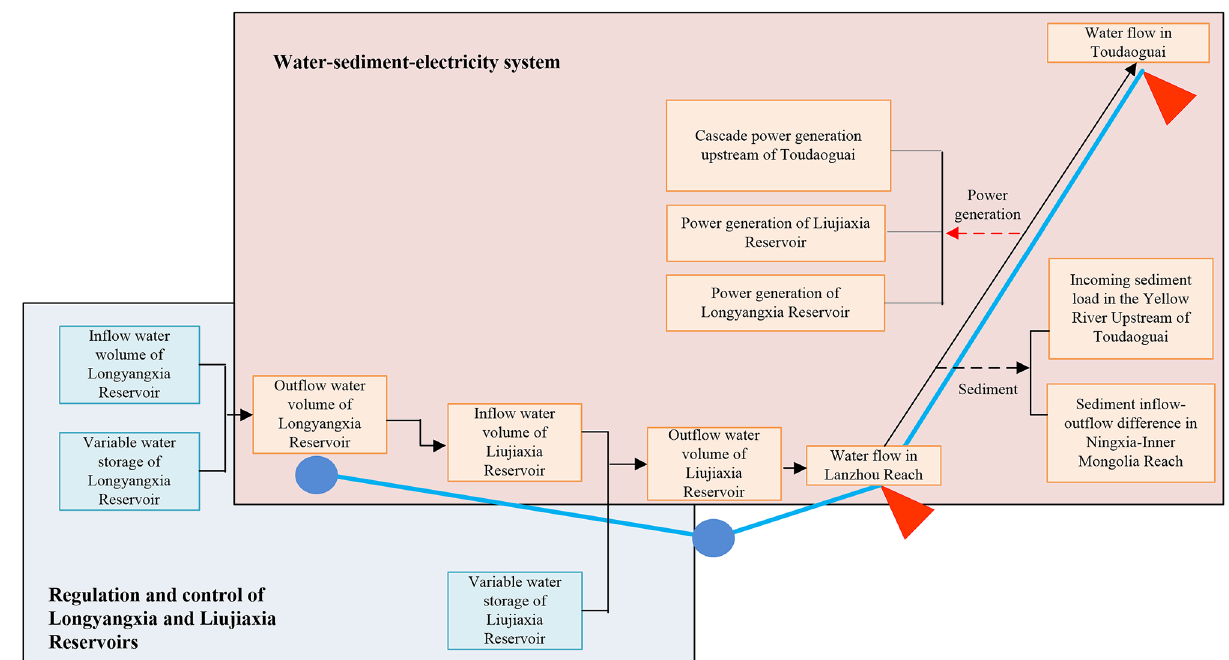
Figure 2. Schematic index classification of the operation system of the Longyangxia and Liujiaxia